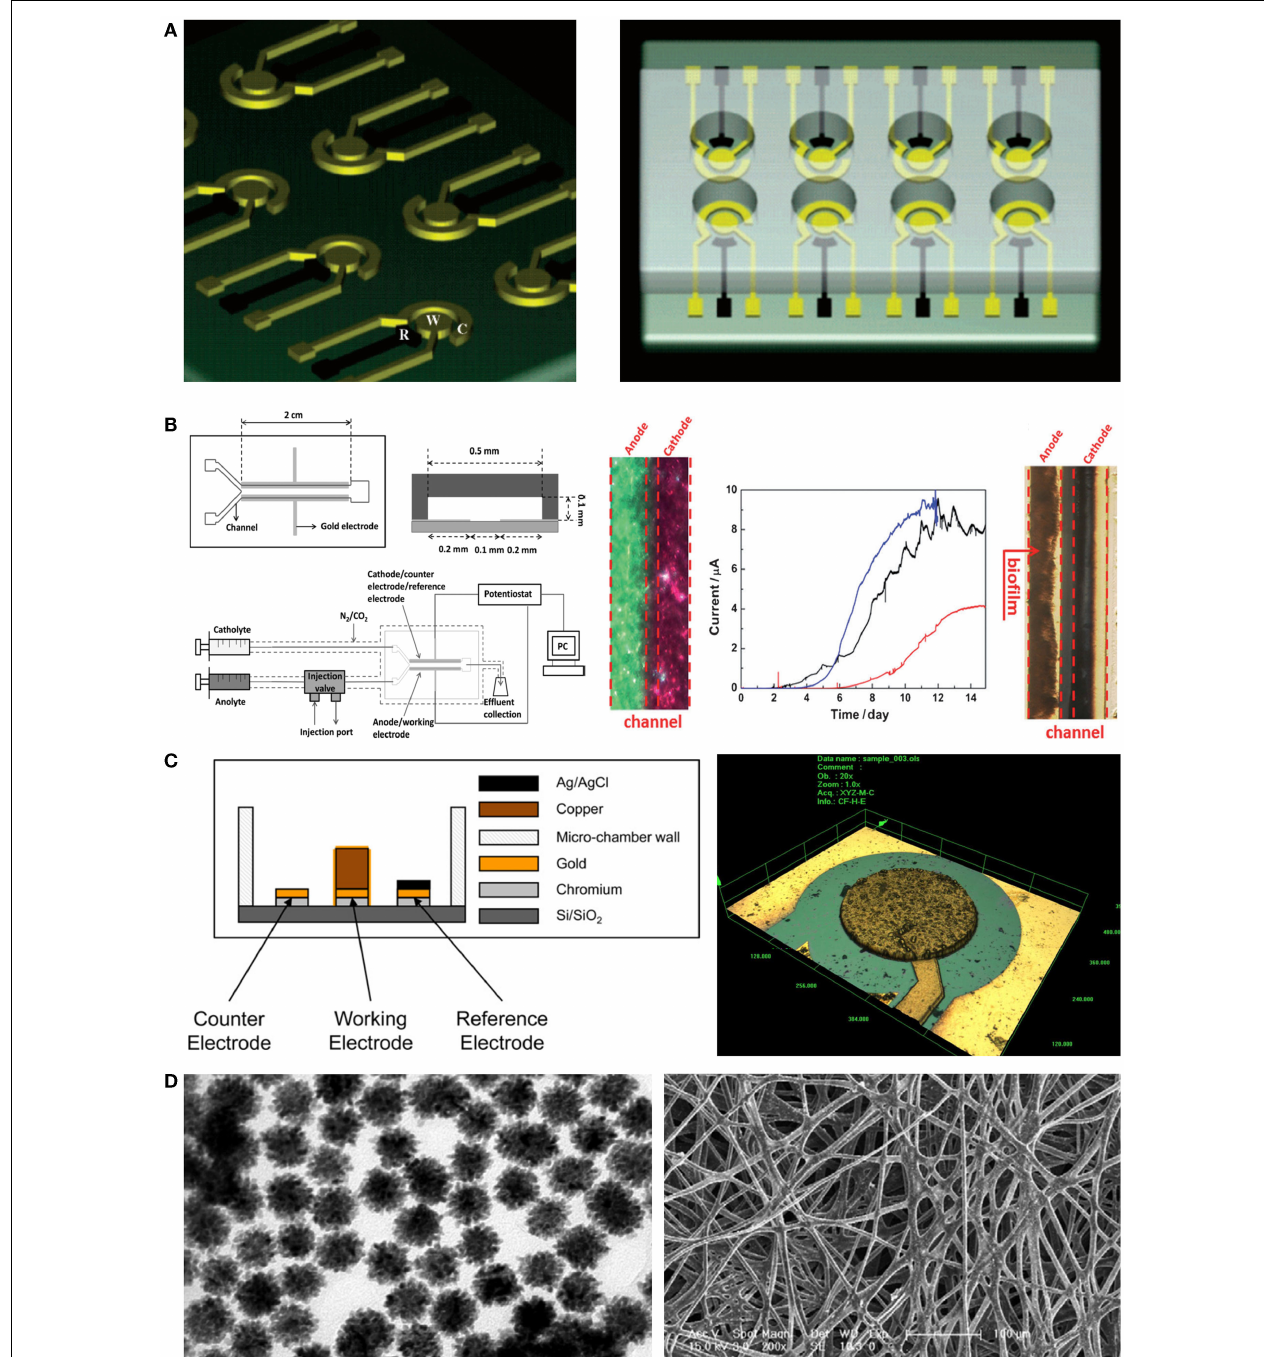
time in electrochemical detection. The figure is reproduced with the permission from Li et al. (2012) [Copyright (2012) John Wiley and Sons, Inc.]. (C) Electrodes were fabricated by using microfabrication techniques including deep reactive ion etching and then applied to microbial biosensors. Since the microstructured electrodes enhanced electric signal from microbial biosensors, the induction factor improved over two times. The figure is reproduced with the permission from Ben-Yoav et al. (2012) [Copyright (2012) Elsevier B. V.]. (D) Metallic nanoparticles integrated with silk microfibers showed remarkable sensing ability for the detection of glucose in various concentrations. The figure is reproduced with the permission from Deng et al. (2010) [Copyright (2010) Elsevier B.